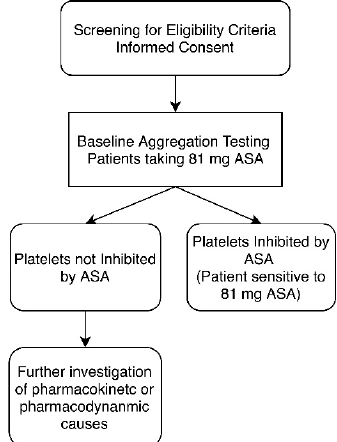
Figure 1. Study design for aspirin (acetylsalicylic acid (ASA)) sensitivity testing. Once patient eligibility was established, each patient underwent light transmission aggregometry (LTA) testing to establish platelet aggregation after activation with arachidonic